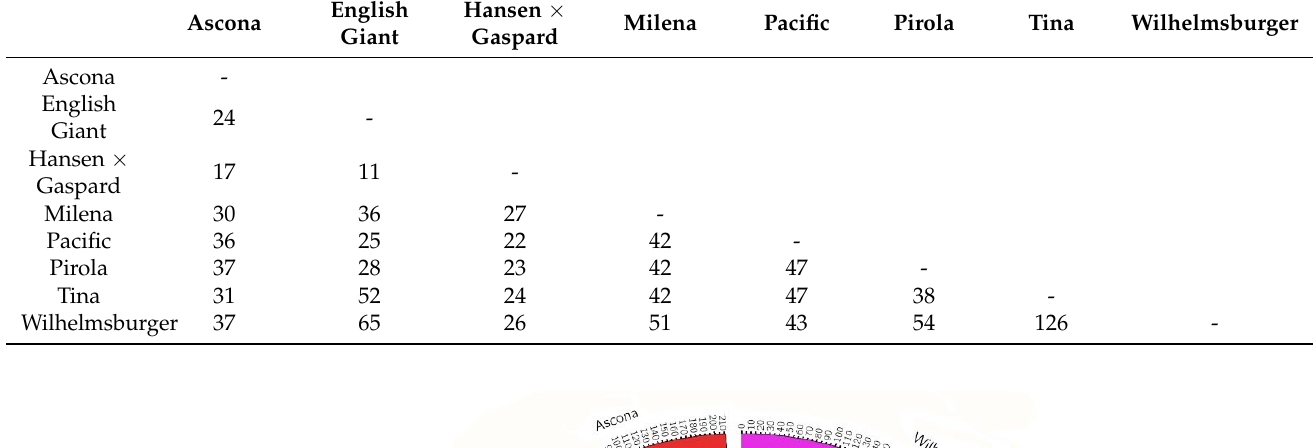
Table 3. The number and percentage of RGAs with CNV shared among the cultivars.